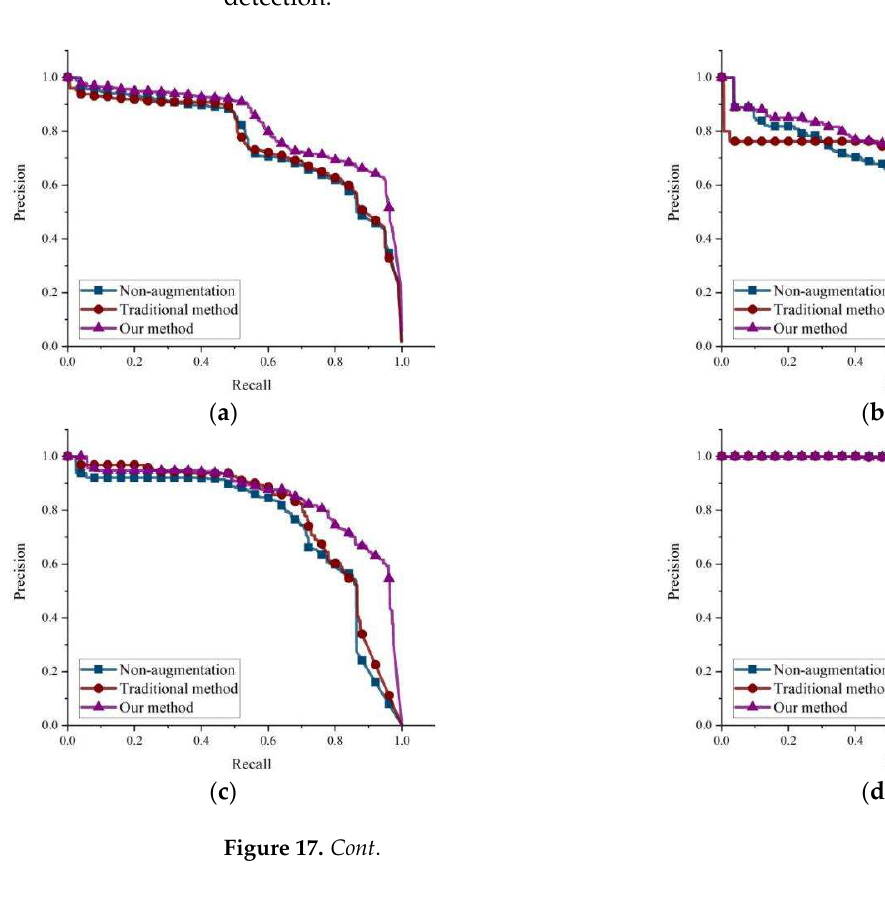
Figure 16. Comparison of AP mask .